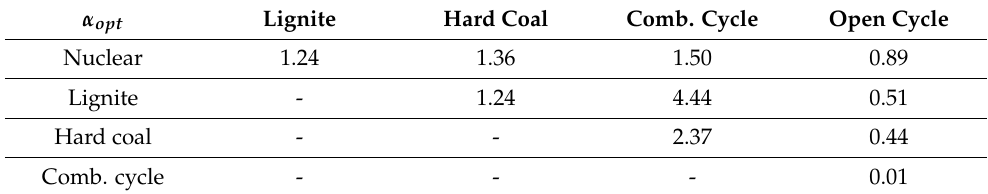
Table A2. Values of α opt for the thermal